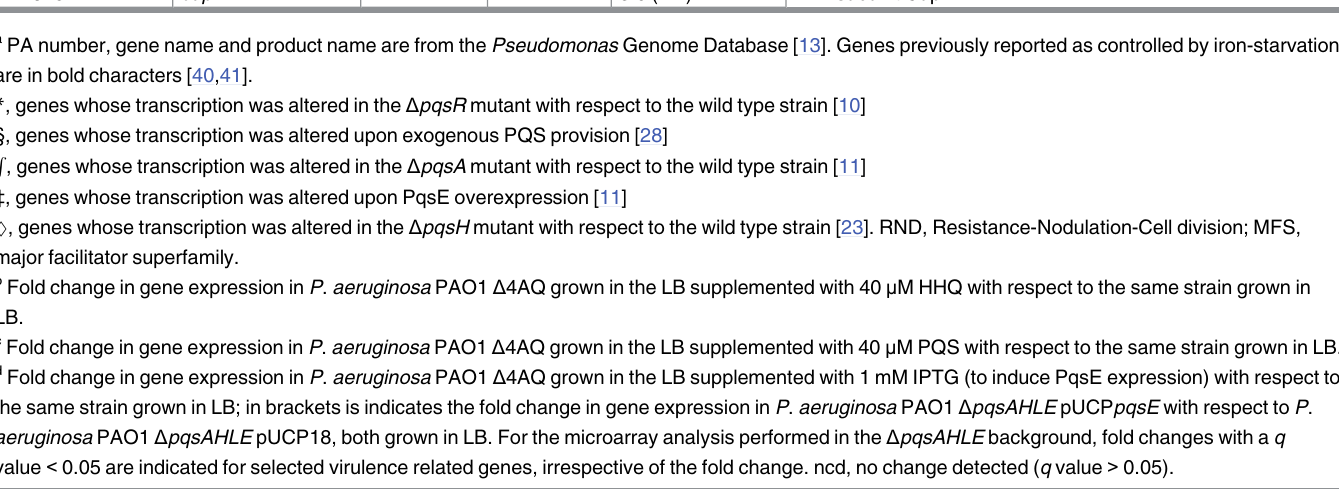
Table for complete list) satisfying this cut-off and hence significantly controlled by the AQs and/or by PqsE. In brief, the RNA levels for 0, 3, 145, and 182 genes were significantly altered by HQNO, HHQ, PqsE and PQS respectively ( Fig 2